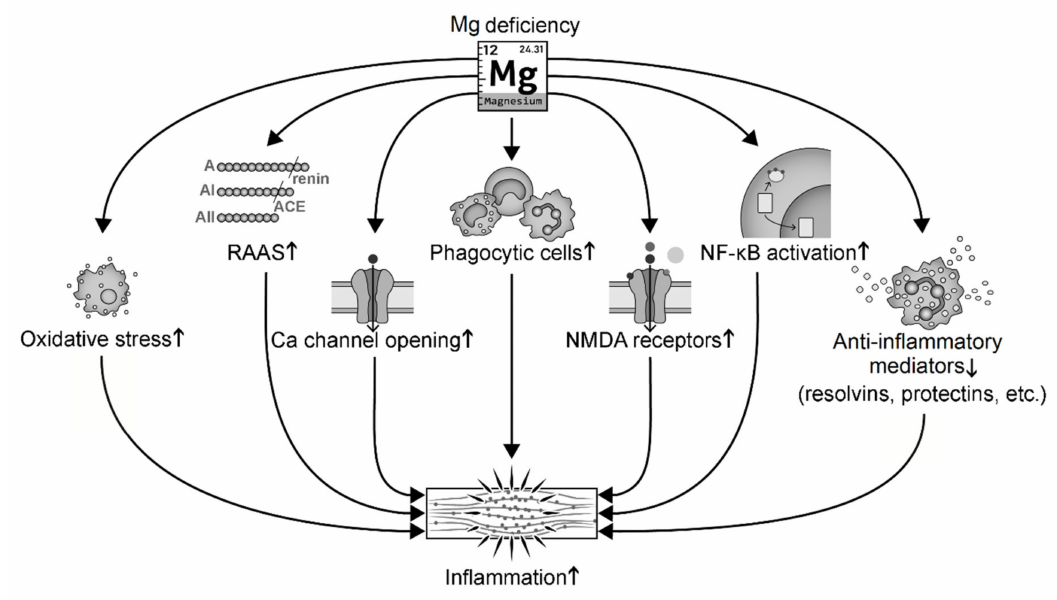
Figure 3. Mg deficiency induces inflammation through several signaling pathways. Abbreviation: NMDA, N-methyl-D-aspartate; RAAS, the renin-angiotensin-aldosterone system. MagT1 conducts Mg influx and plays a key role in T cell-activated immune response